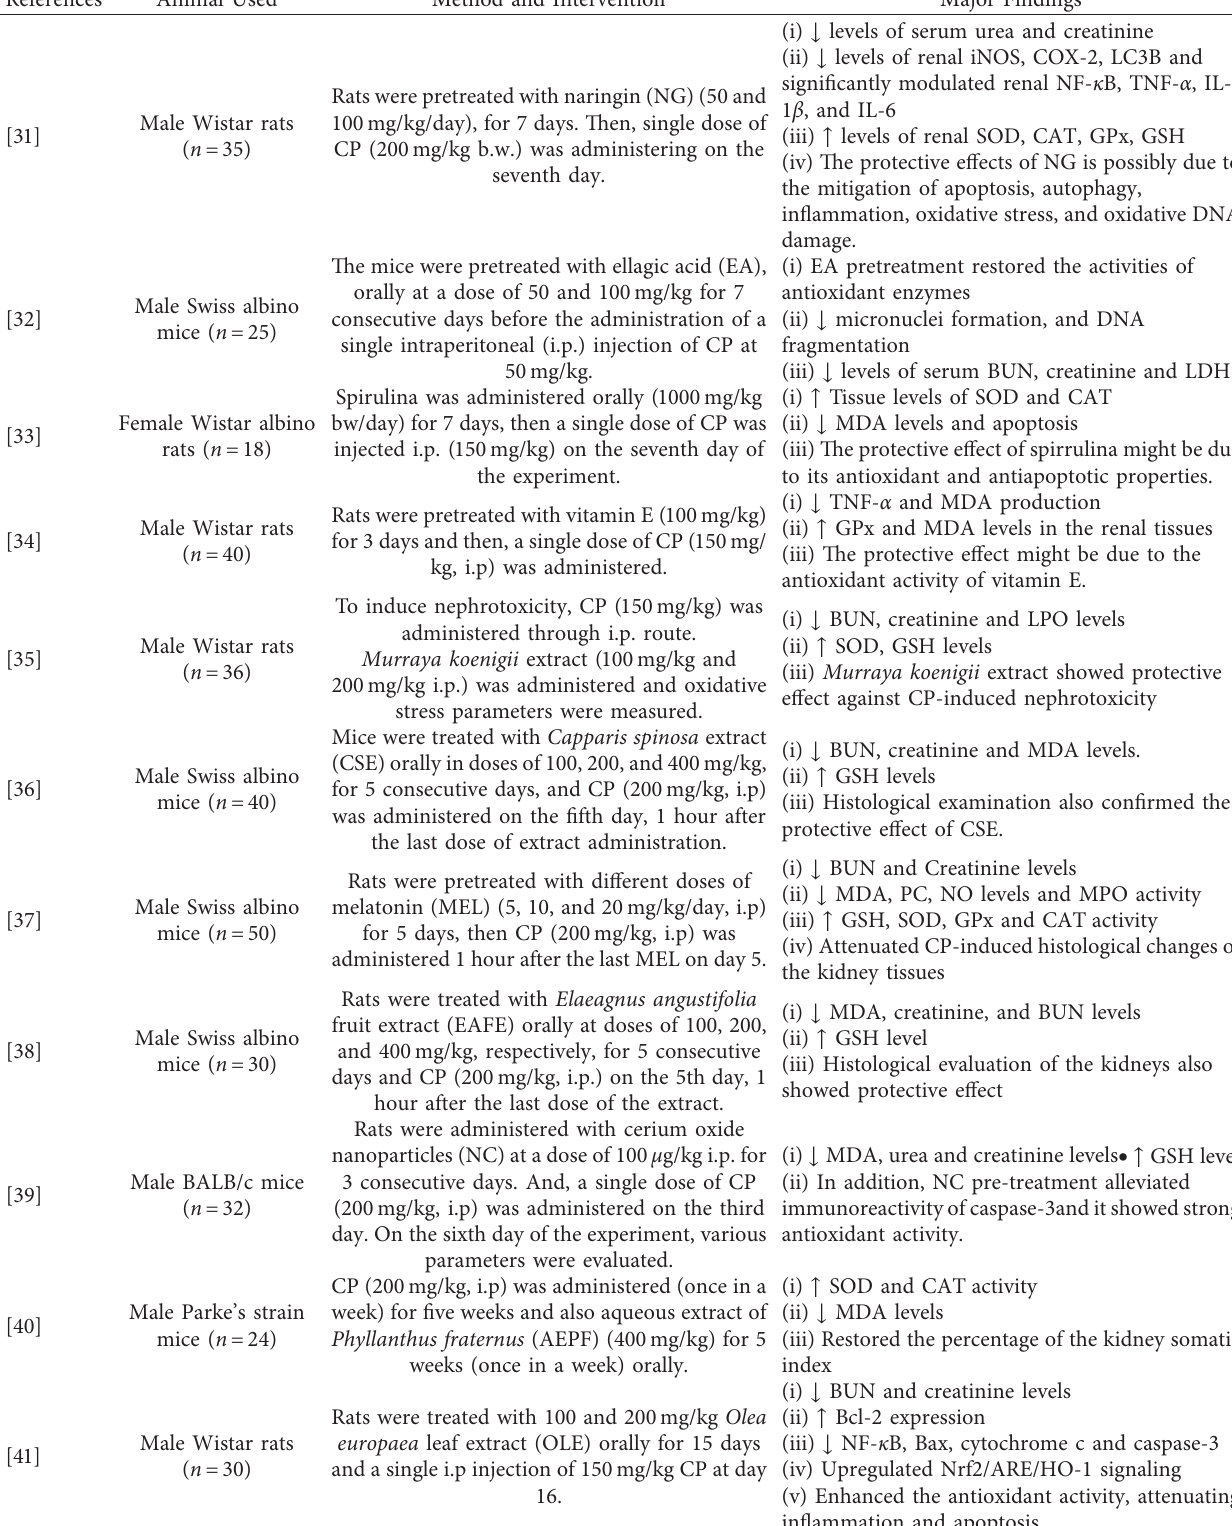
Table 1: Protective role of antioxidants against cyclophosphamide-induced